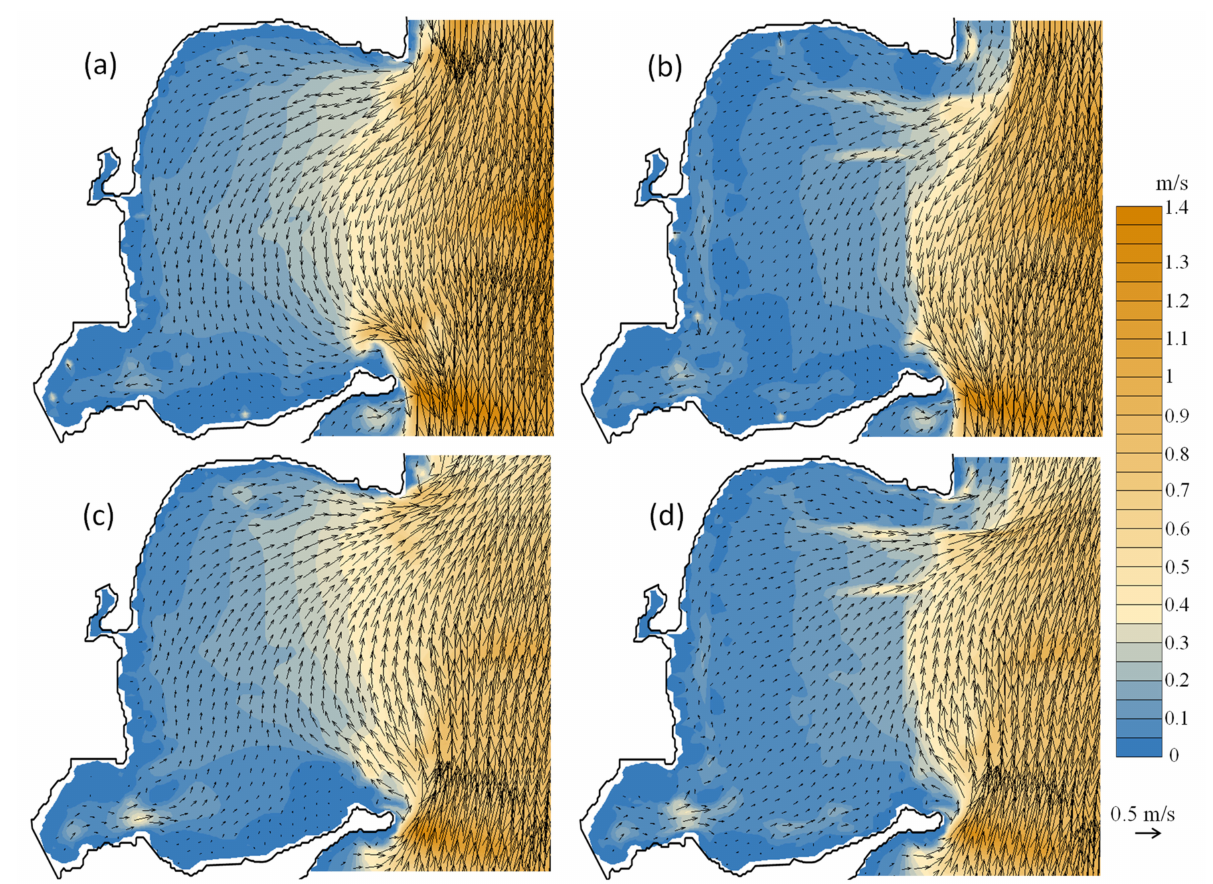
Figure 8. Depth-averaged tidal currents in the bay. Tidal rising for ( a ) non-aquaculture and ( b ) bivalve cultures; tidal ebbing for ( c ) non-aquaculture and ( d ) bivalve cultures. Color bar shows the velocity magnitude. The same period and model configuration were used for simulations of no aquaculture and bivalve cultures.